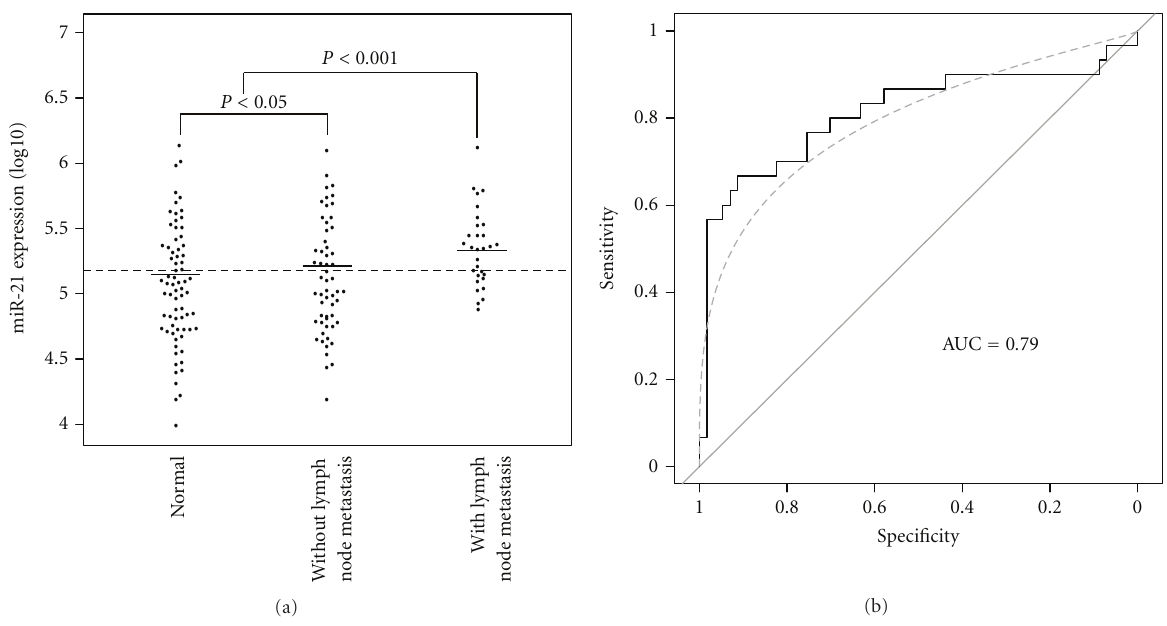
Figure 1: Comparison of levels of miR-21 in samples from gastric cancer (GC) patients without lymph node metastasis ( n = 56), GC patients with lymph node metastasis ( n = 30), and normal controls ( n = 72). The lines denote the medians. Dot lines at the y-axis denote cut-o ff values. A significant di ff erence between all histological groups was examined by ANOVA test. NS denotes no significant di ff erence between groups. Receiver operating characteristics (ROCs) curves were used to discriminate patients with and without lymph node